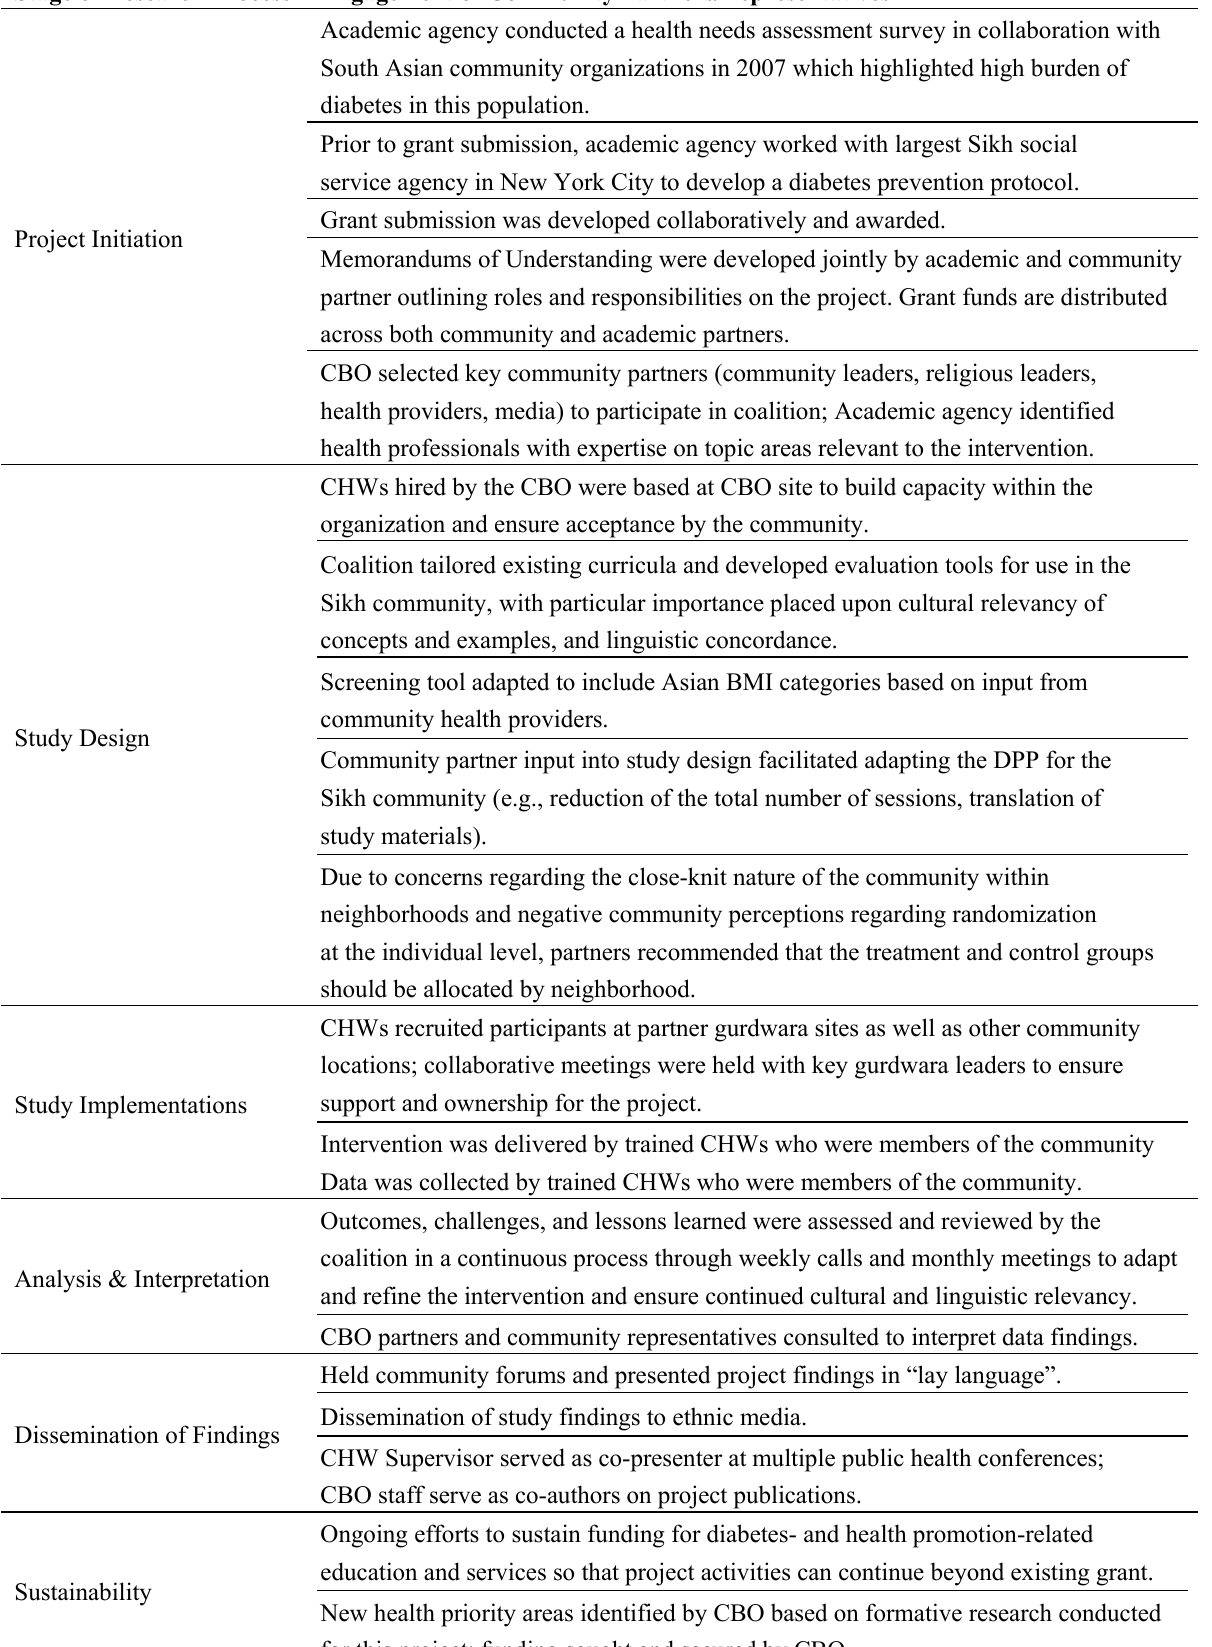
Table 1. Example of Community Engagement through the Research Process. Stage of Research